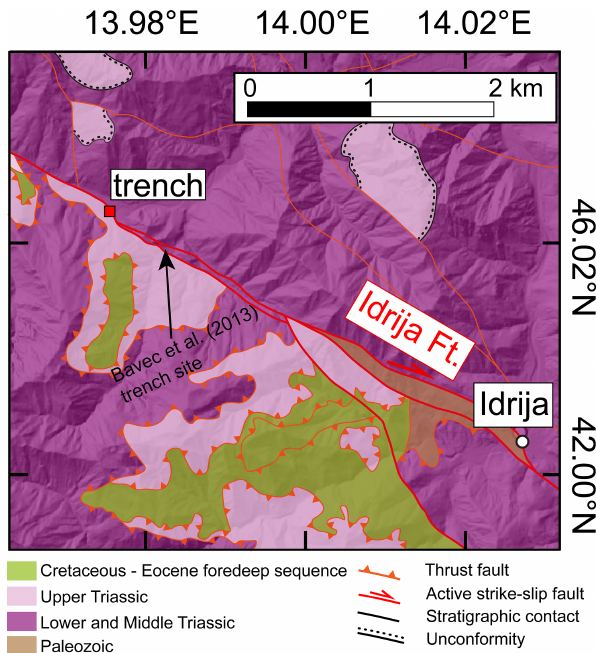
Figure 9. Geological map of the trench site at the Idrija Fault. Sim- plified from Mlakar and ˇCar (2010). Same extent as the inset in Fig.